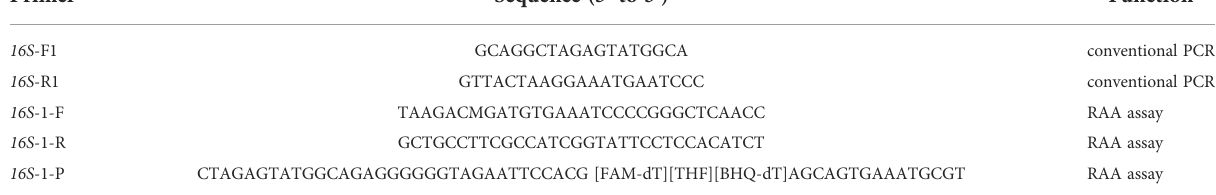
TABLE 1 The primer sequences used in the